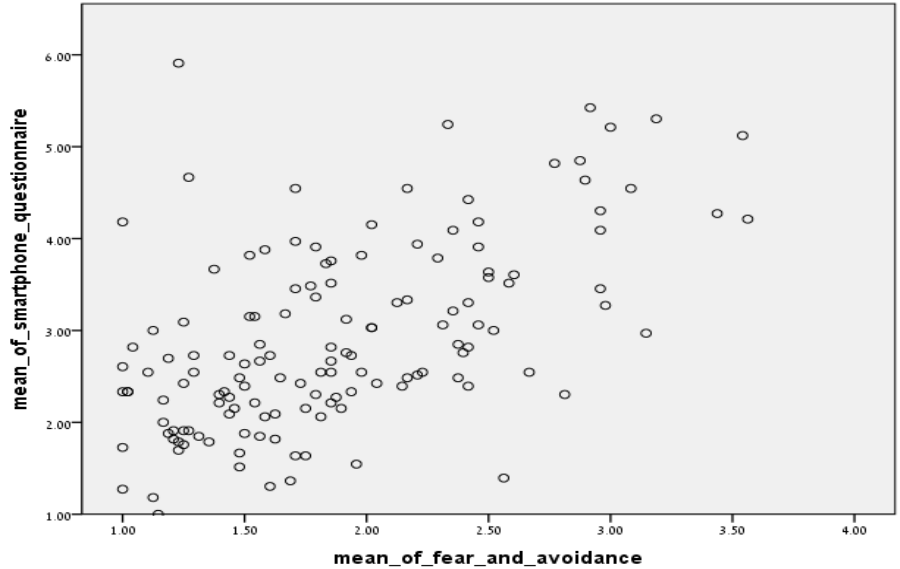
Figure 1. The association between problematic smartphone use and social anxiety.